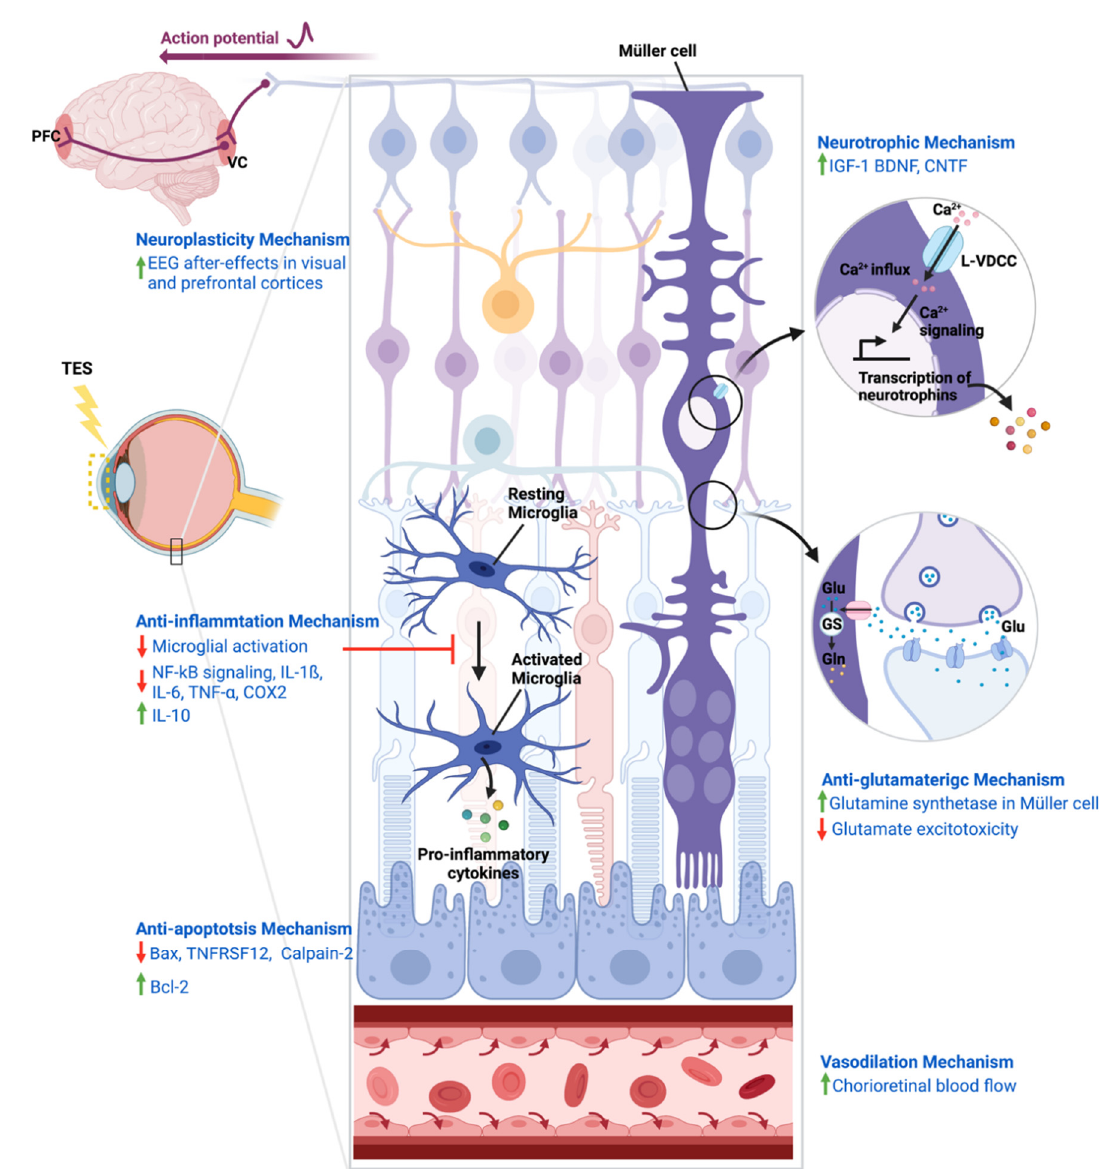
Figure 2. Potential mechanisms of the action of TES. The diagram shows the enlarged structures in retinal layers